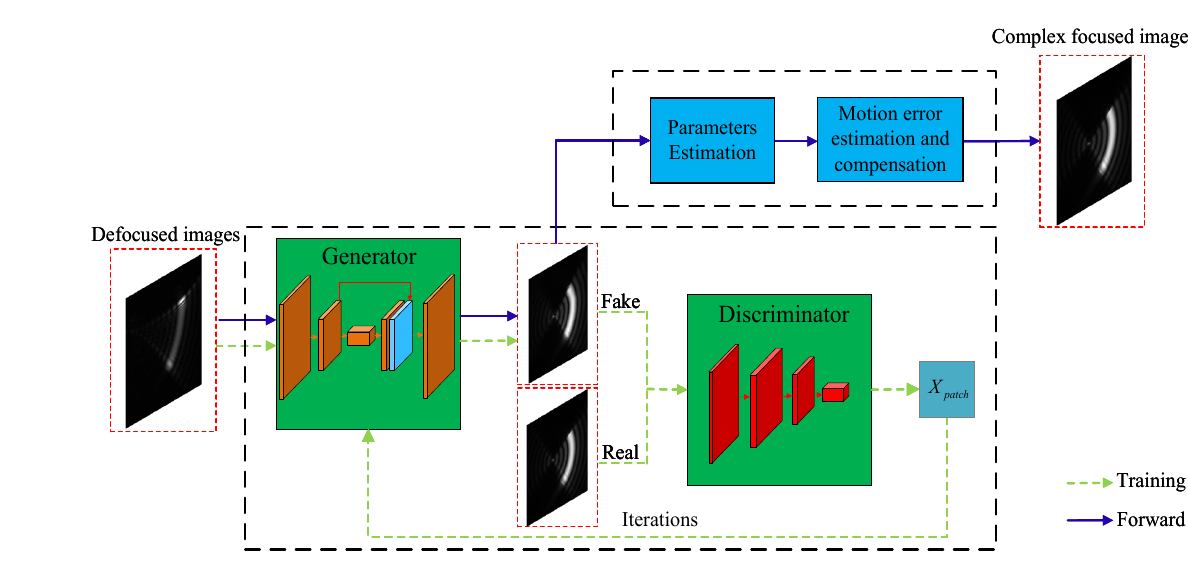
Figure 5. The flowchart of the proposed